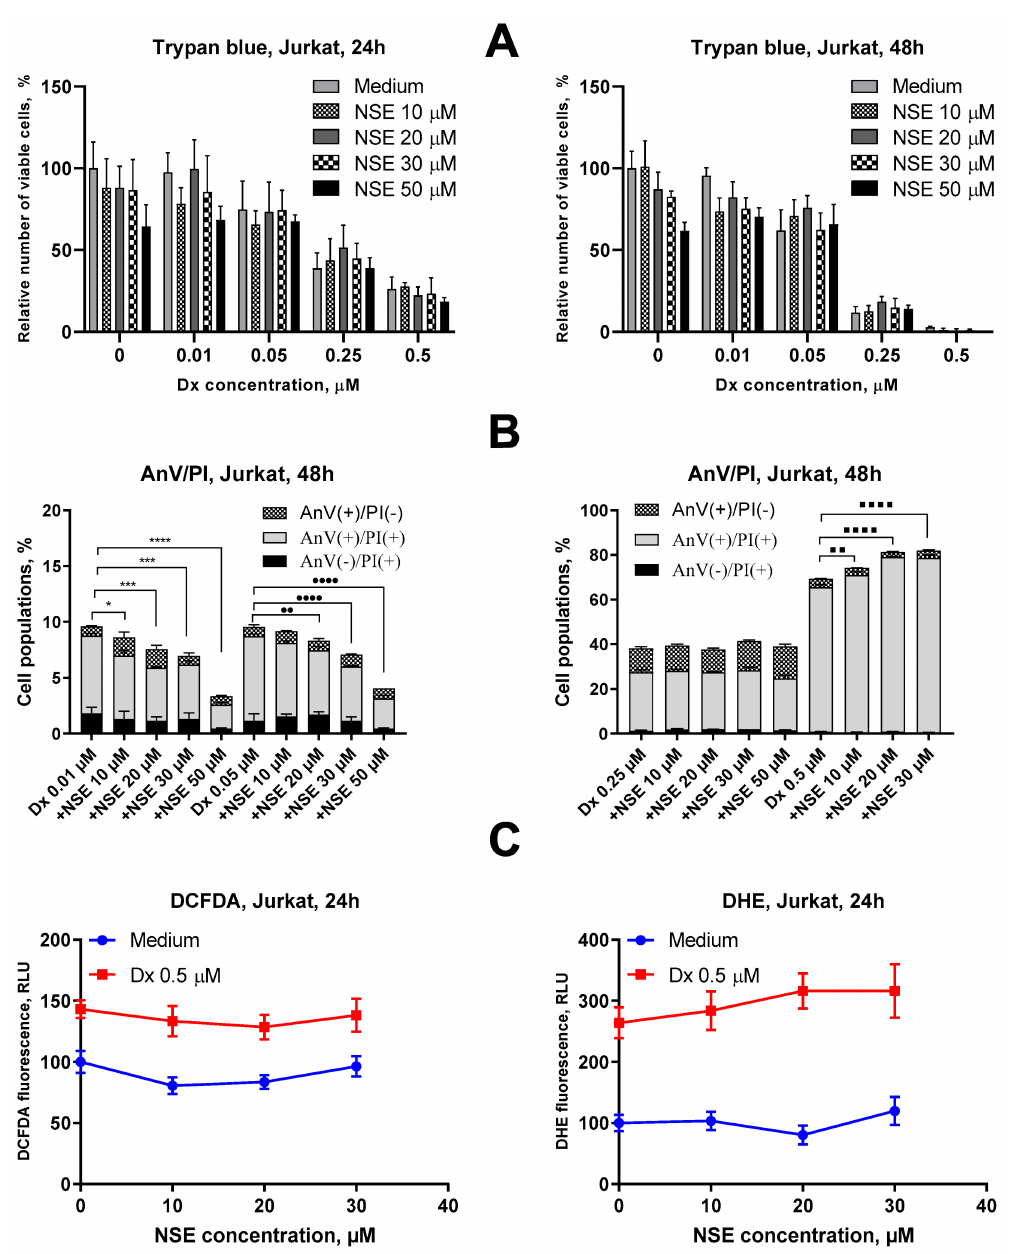
Figure 4. Impact of the combination of NSE and Dx in vitro. ( A ) Viability of Jurkat cells after treatment with various concentrations of Dx and/or NSE for 24 h and 48 h, analyzed by trypan blue exclusion. ( B ) Phosphatidylserine externalization in Jurkat cells after treatment with various concentrations of Dx and/or NSE for 48 h. Flow cytometry, APC-annexin V, and PI double staining. ( C ) Impact of co-treatment with NSE and Dx on H 2 O 2 and O 2 − levels in Jurkat cells. Flow cytometry, DCFDA, and DHE staining, respectively, 24 h incubation. The effect of NSE and/or Dx on cell growth and ROS production was plotted relative to the untreated control. Data given represent the mean ± SD of three independent experiments done in triplicates. Significance to control and other groups was calculated with one-way ANOVA and Tukey’s multiple comparison test (* p ≤ 0.05, *** p < 0.001, **** p < 0.0001—differences in number of AnV(+)/PI(+) cells relative to Dx 0.01 µ